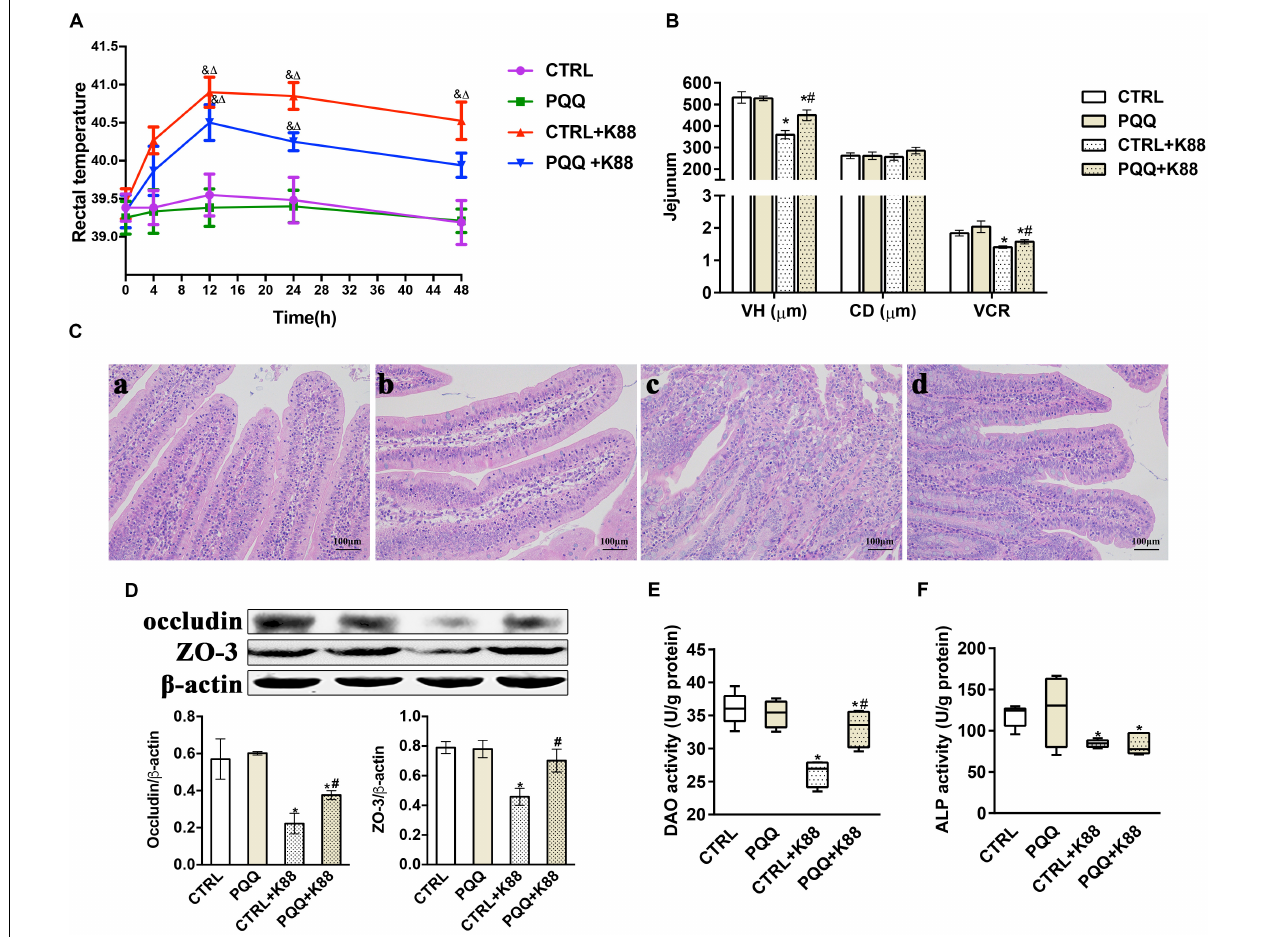
FIGURE 1 | Effect of pyrroloquinoline quinone (PQQ) on rectal temperature and jejunal morphology in piglets challenged with enterotoxigenic Escherichia coli (ETEC) K88. (A) Body temperature of piglets was measured using digital thermometers; peak temperature was measured 12 h after the challenge. (B) The villus height (VH), crypt depth (CD), and villus height/crypt depth ratio (VCR) of the jejunum. (C) Hematoxylin-eosin staining was used to observe the jejunal morphology. (C-a) is from the group fed the basal diet (CTRL group); (C-b) is from the group fed the basal diet with PQQ and not challenged with ETEC K88 (PQQ group); (C-c) is from the group fed the basal diet without PQQ and challenged with ETEC K88 (CTRL + K88); and (C-d) is of the group fed the basal diet supplemented with PQQ and challenged with ETEC K88 (PQQ + K88). (D) Western blot analysis of occludin and ZO-3, and the densitometric values of tight junctions normalized to β -actin expression. (E,F) Protein levels of DAO and ALP in the jejunum. CTRL, piglets fed the basal diet; PQQ, piglets fed the basal diet supplemented with PQQ; CTRL + K88, piglets fed the basal diet and challenged with ETEC K88; PQQ + K88, piglets fed the basal diet supplemented with PQQ and challenged with ETEC K88. & represents comparison of hourly body temperature with that recorded 0 h after treatment ( P < 0.05). δ represents comparison of hourly body temperature with the temperature of the CTRL group at the corresponding hour ( P < 0.05). * denotes a significant difference ( P < 0.05) from the CTRL group. # denotes a significant difference ( P < 0.05) from the CTRL + K88 group. Data are presented as mean ± SEM; n = 5.